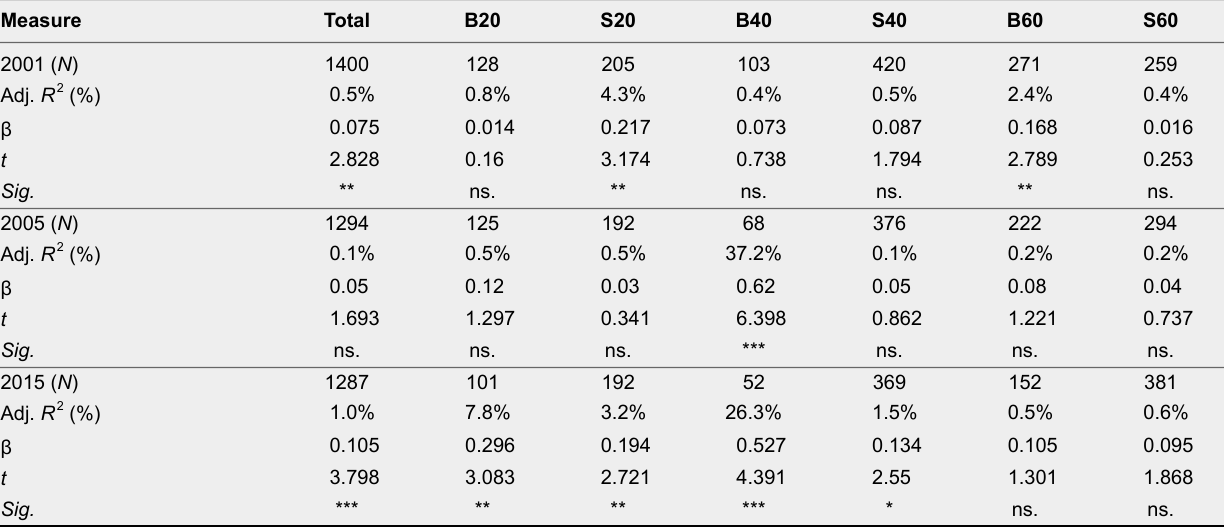
A Summary of 21 Regression